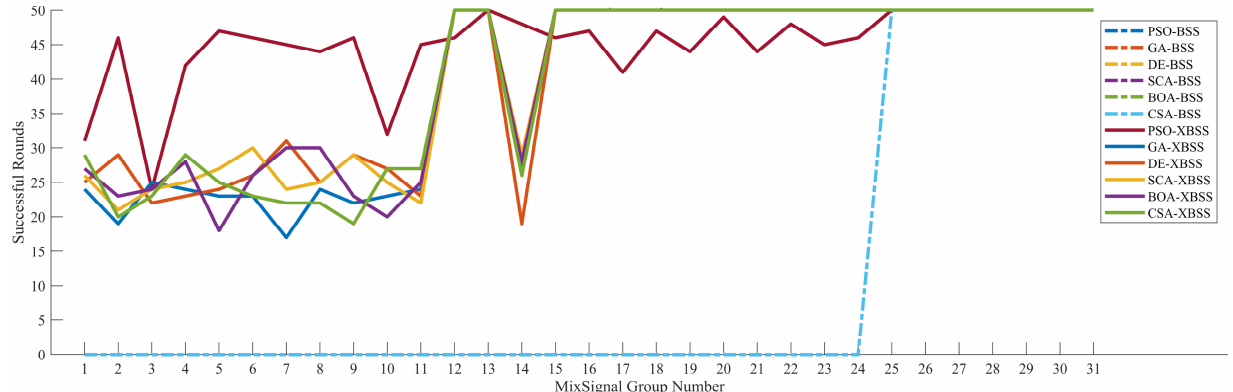
Figure 11. The stability of the complete separated of 12 algorithms. The results of the SI-BSS of